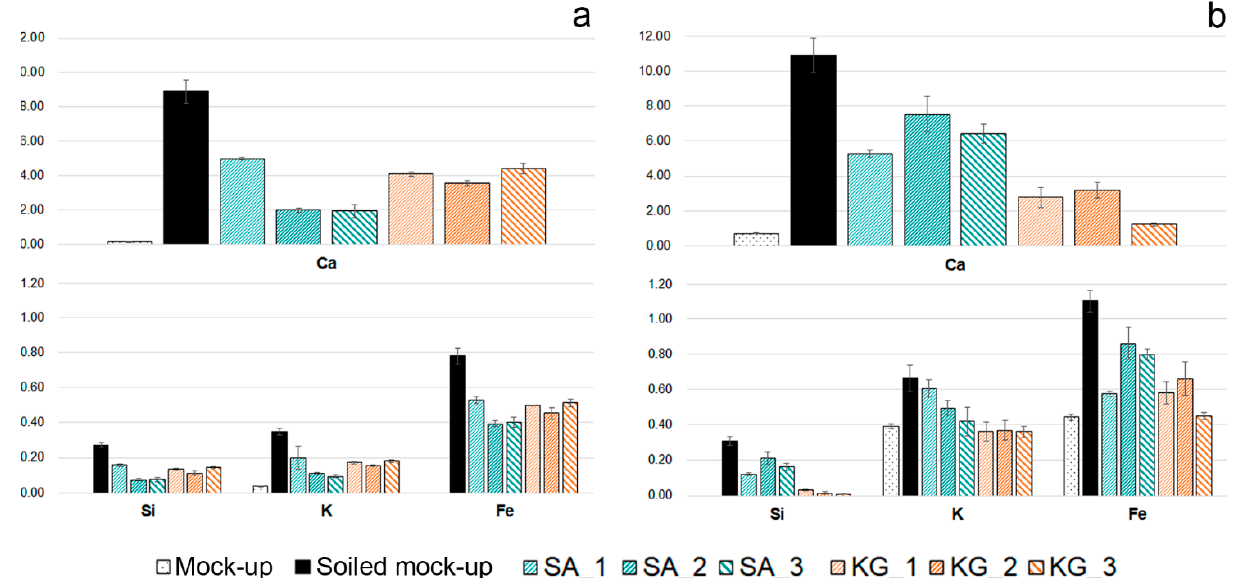
Figure 7. Normalized counts of Ca, Si, K, and Fe detected on ( a ) WM and ( b ) EAM. Different bars correspond to clean mock-ups (WM and EAM); to soiled mock-ups (soiled-WM and soiled-EAM); and to the soiled mock-ups after 1, 2, and 3 applications of SA (SA_1, SA_2, SA_3) and KG gels (KG_1, KG_2, KG_3). XRF values correspond to the net area counts of the K α peak of each element normalized to time and to the average of the entire dataset of net area counts of the Rh-K α peak with the related standard deviation.